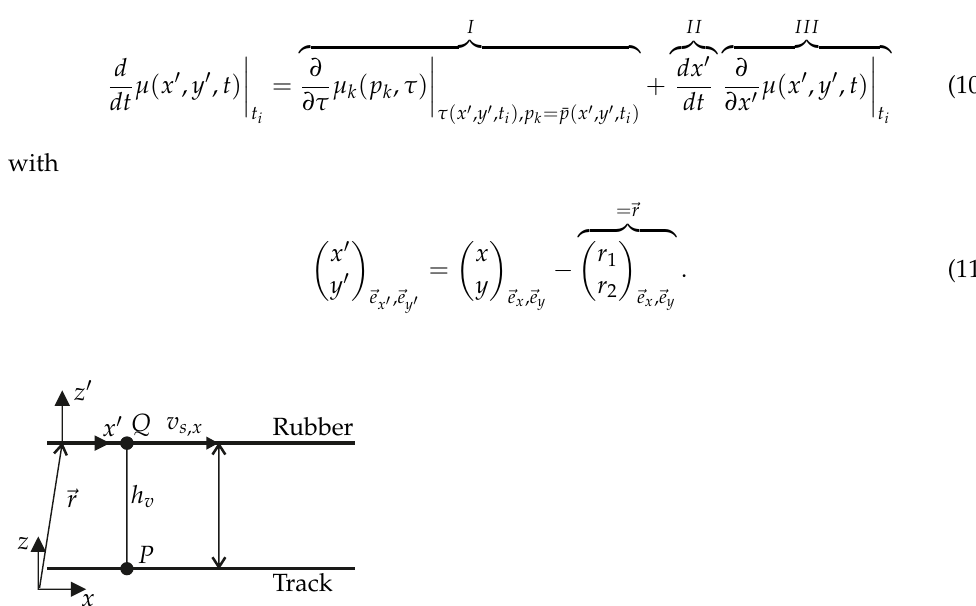
Figure 6. Fixed inertial coordinate system x , y and rubber fixed relative coordinate system x (cid:48) , y (cid:48) . The vector (cid:126) r indicates the shift of the relative coordinate system with respect to the inertial